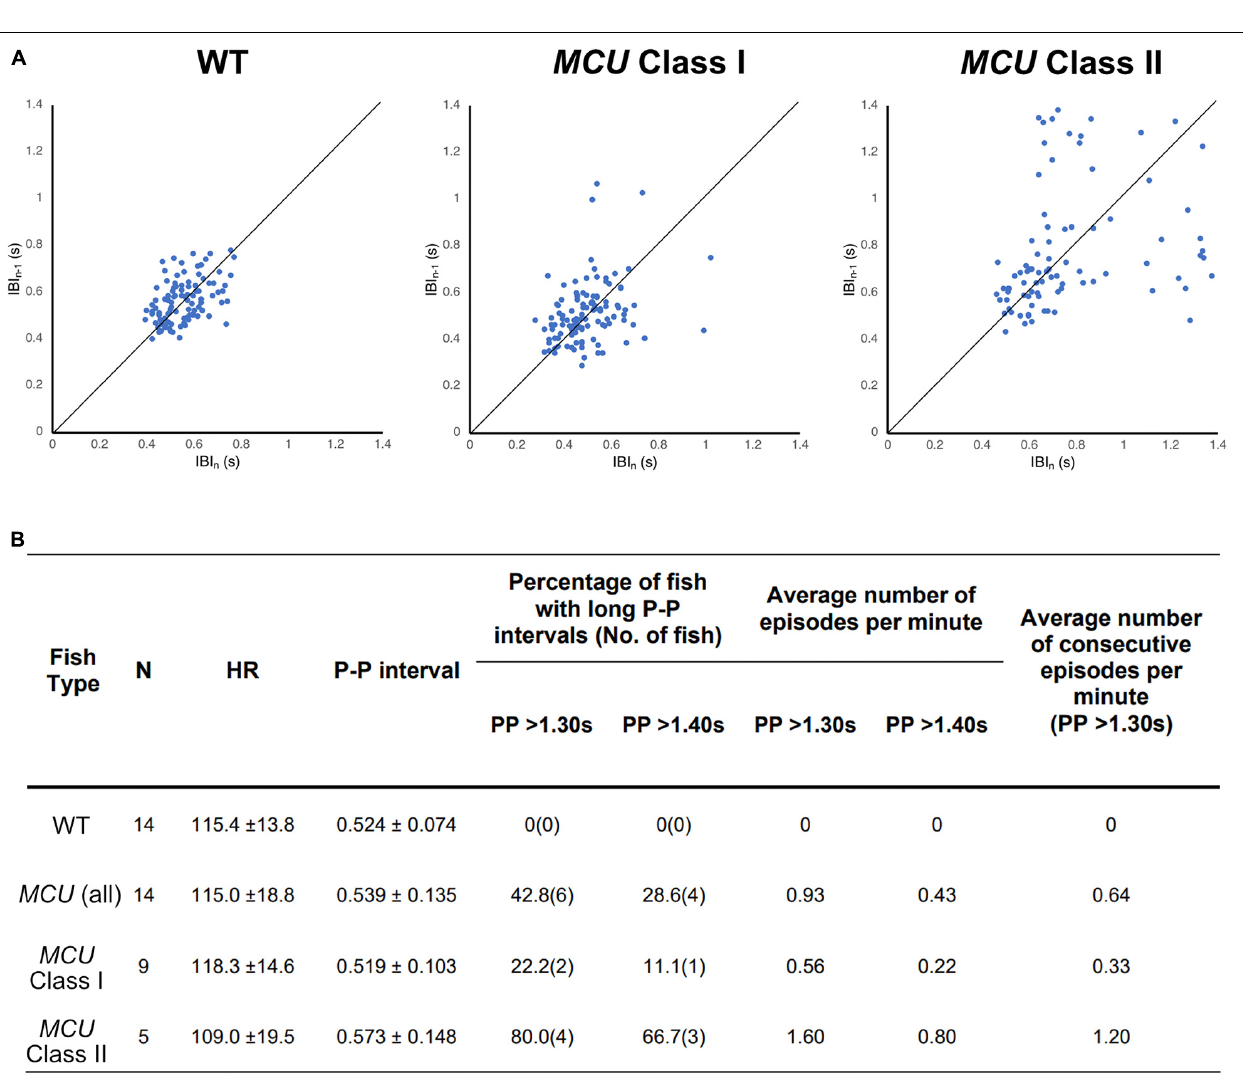
FIGURE 5 | Analysis on cardiac arrhythmia in MCU mutant. (A) Increased heartbeat variability in MCU mutants displayed via Poincaré plots of consecutively occurring P - P intervals in adult wildtype and MCU mutant fish. (B) Summary of ECG data from 14 wildtype fish and 14 MCU mutant fish. Different cut-offs of P - P intervals were used to classify severity and definitive of occurring sinoatrial block episodes. Increased sample percentage with SA block episodes, per minute frequency, and consecutively occurring episodes were identified in MCU mutant (compared to wildtype), and further emphasized in MCU Class II